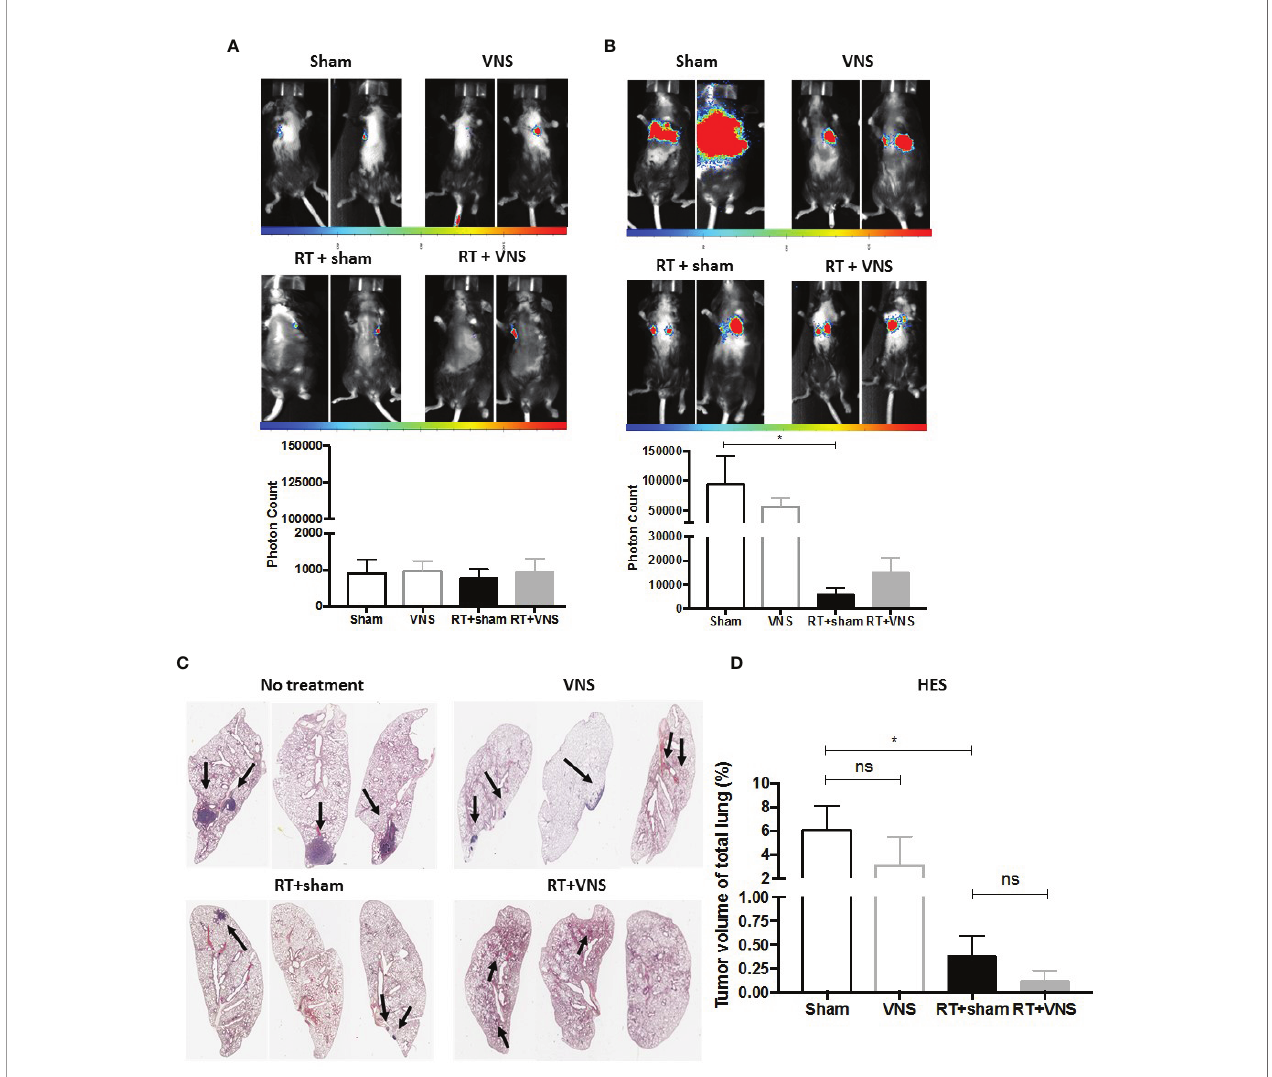
FIGURE 3 | Therapeutic impact of VNS mono- or combitreatment with RT. (A, B) On day 7 and 19, lung tumors were evaluated using in vivo BLI. Images of two animals from 4 different treatment groups on (A) day 7 and (B) day 19 with the integrated light signal of 7 minutes at peak activity and photon counts as a measure of tumor size according to ROI. (C) Lung histopathology of formalin- fi xed, paraf fi n-embedded lung tissue stained with HES. (D) Histology measured nodule volume shown as percentage (%) of total lung volume. Data are shown as mean ± SD of n=4 (sham), n=5 (VNS), n=5 (RT) and n=5 (VNS+RT). *P < 0,0332 by two-tailed unpaired t-tests. ns, non signi fi